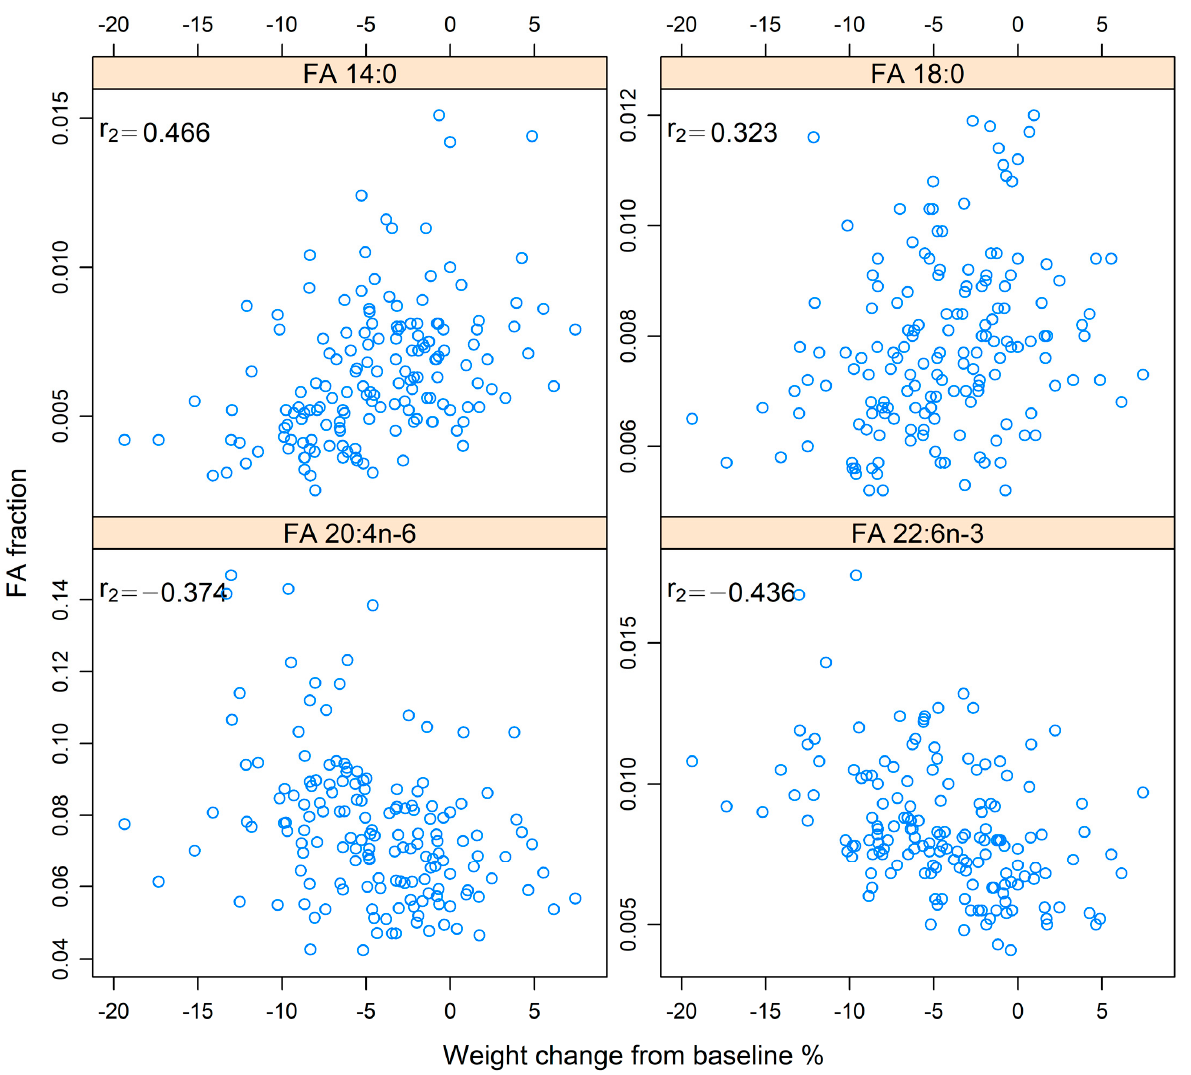
Figure 4. Spearman’s rank correlation (r s ) between fatty acids (FAs) 14:0, 18:0, 20:4n-6, and 22:6n-3 and percent body weight changes from baseline to 7 weeks in patients with head and neck cancer. The values for the FAs are presented in relation to the total amount of FAs. The x -axis shows percent body weight change from